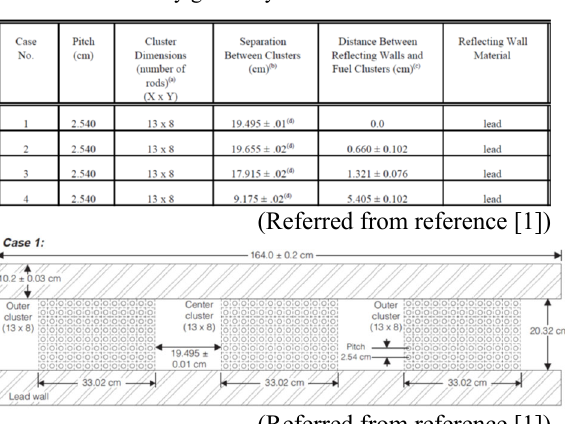
Fig. 7. Arrays of fuel rods of LCT-010 case 1.